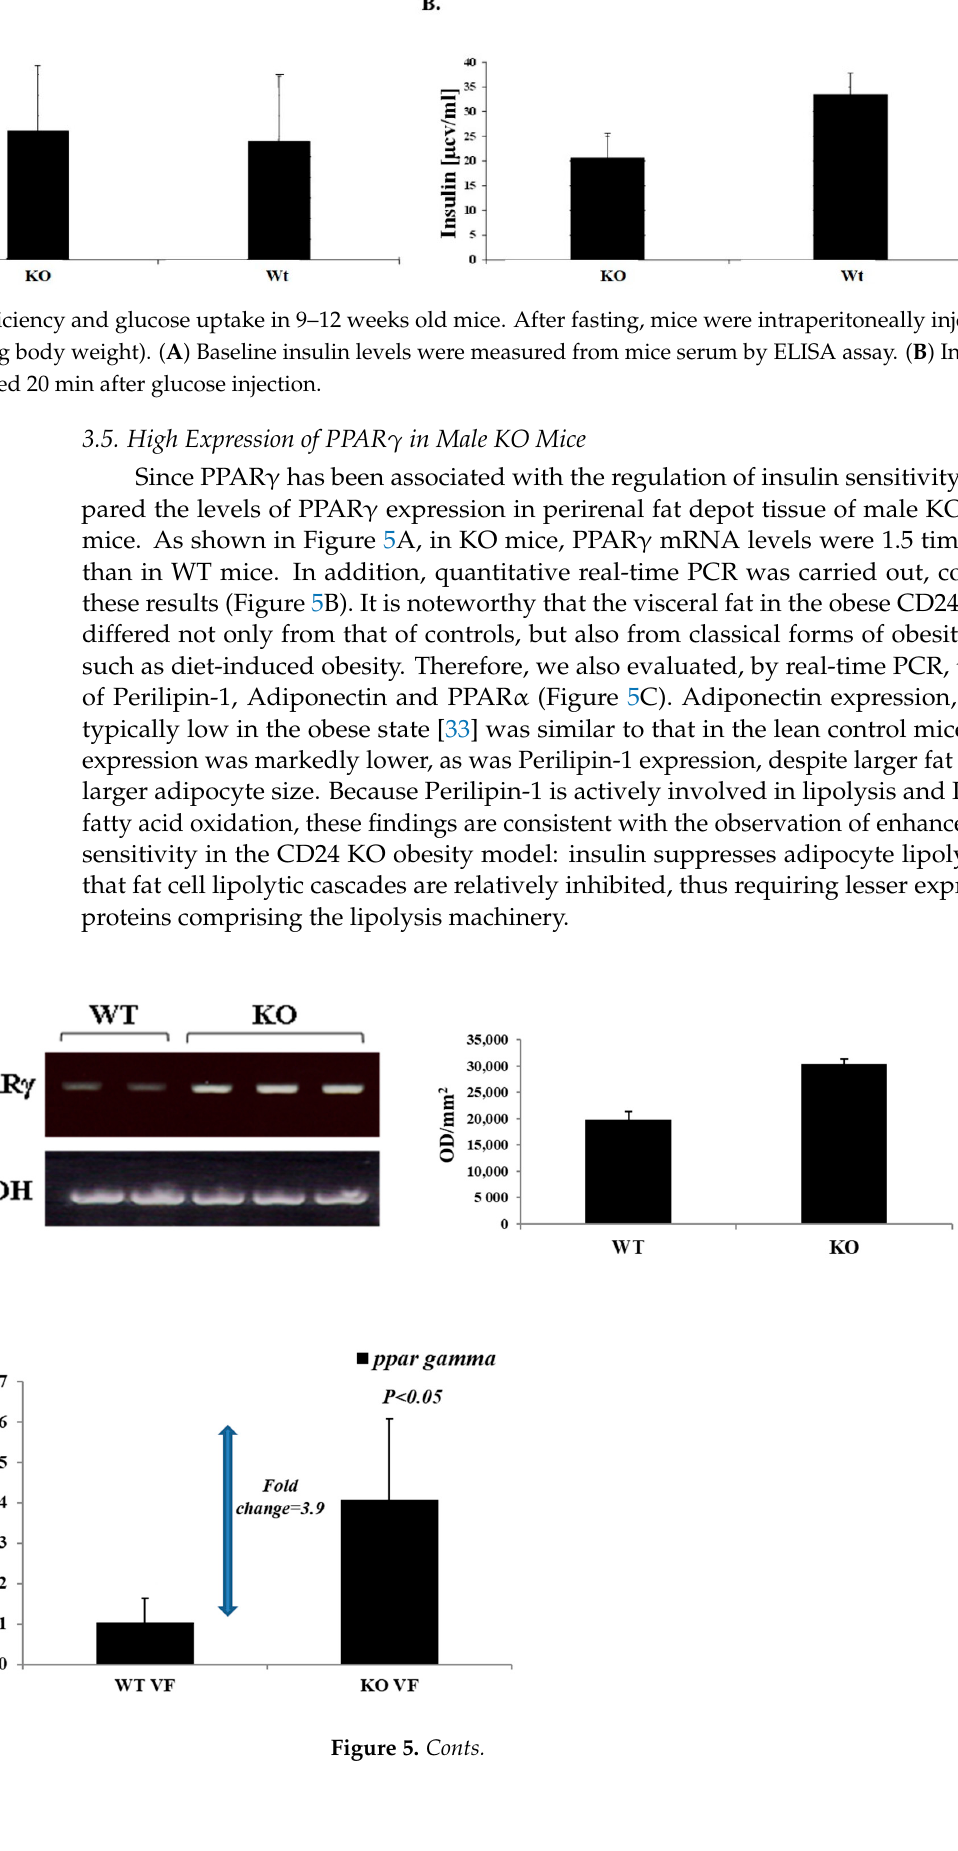
Figure 5. PPAR γ expression in KO and WT male mice. RNA extraction from kidney adipose tissue from KO and WTmice was prepared and cDNA synthesis was performed. ( A ). A fragment of the PPAR γ gene was amplified by PCR reaction and uniformity of the samples was confirmed by the murine GAPDH housekeeping gene. PPAR γ expression levels in samples, shown on the right, were determined by densitometry (TINA 2.0). ( B ). Quantitative real-time PCR was performed to confirm the results above. ( C ). Quantitative real-time PCR was performed to determine the levels of perilipin 1, PPAR α , and adiponectin in visceral fat. 3.6. Differences in Adipocyte Size Adipocyte increased cell size (hypertrophy) has been associated with obesity in hu- mans [19,22]. Therefore, we compared adipocyte size between KO and WT genotypes. As shown in Figure 6, KO mice showed statistically significant increase in adipose cell size, as demonstrated through the white adipocyte tissue (WAT) cell area of 8258 ± 2359 µm 2 in KO mice and 5471 ± 2030 µm 2 in WT mice.